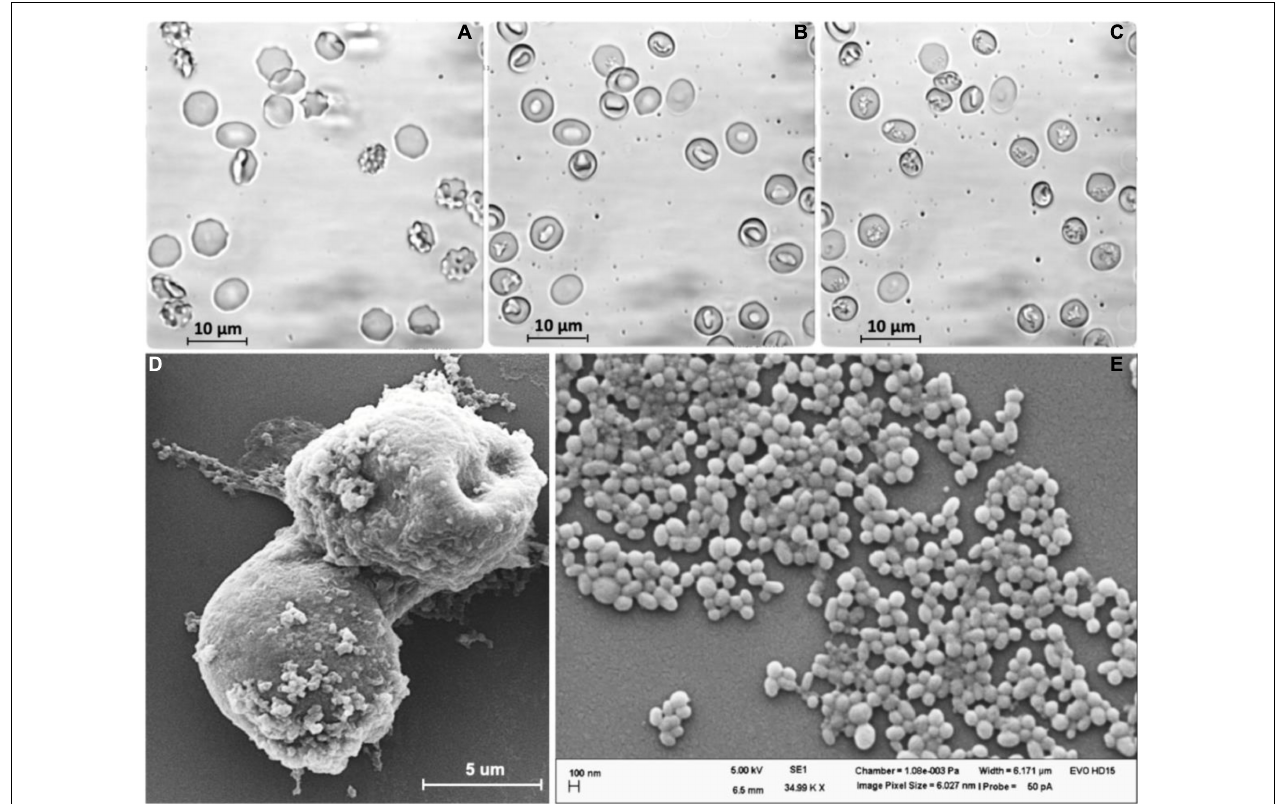
FIGURE 1 | Extracellular vesicles (EVs) were released from human red blood cells (RBCs) stimulated by PMA (6 µ M) after (A) 0 min, (B) 15 min, and (C) 60 min. (D) SEM analysis of stimulated RBCs treated by PMA after 60 min. (E) EVs released from